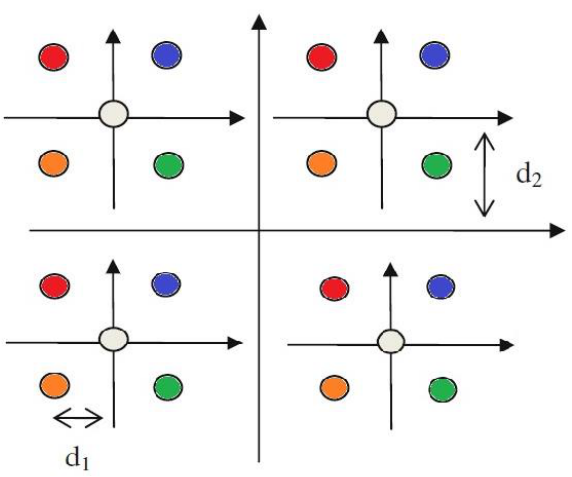
Figure 3. Partitioning of 16-QAM utilizing (N = 4)-way segments and L = 2. However, the array has been increased to make the constellation points for 64 QAM.